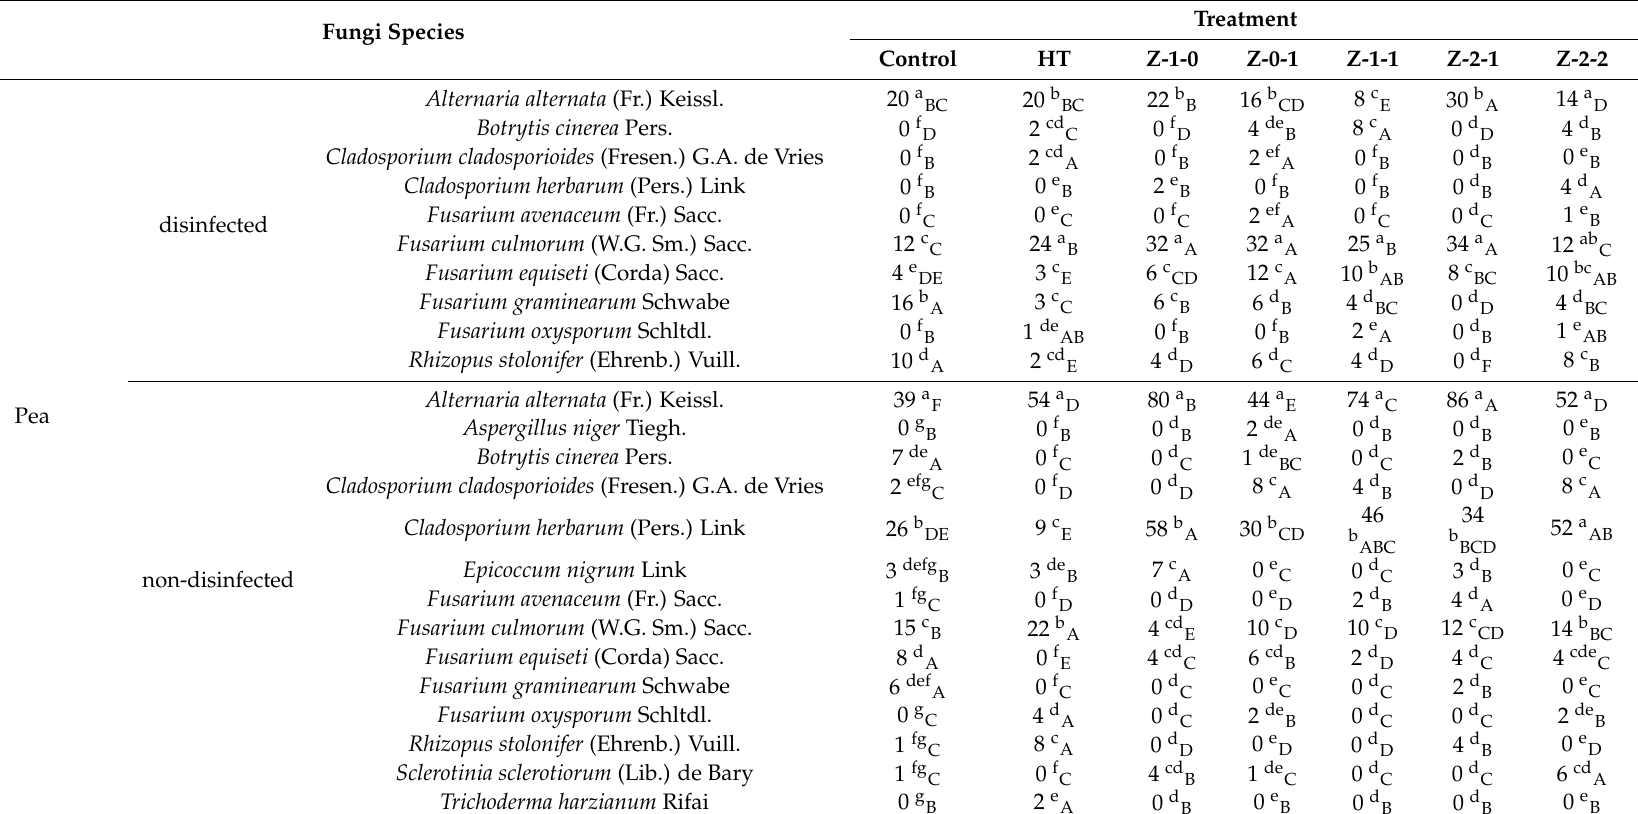
Table A3. Cont. Treatment Fungi Species Control HT Z-1-0 Z-0-1 Z-1-1 Z-2-1 Z-2-2 Alternaria alternata (Fr.) Keissl. 20 a BC 20 b BC 22 b B 16 b CD 8 c E 30 b A 14 a D Botrytis cinerea Pers. 0 f D 2 cd C 0 f D 4 de B 8 c A 0 d D 4 d B Cladosporium cladosporioides (Fresen.) G.A. de Vries 0 f B 2 cd A 0 f B 2 ef A 0 f B 0 d B 0 e B Cladosporium herbarum (Pers.) Link 0 f B 0 e B 2 e B 0 f B 0 f B 0 d B 4 d A Fusarium avenaceum (Fr.) Sacc. 0 f C 0 e C 0 f C 2 ef A 0 f C 0 d C 1 e B disinfected Fusarium culmorum (W.G. Sm.) Sacc. 12 c C 24 a B 32 a A 32 a A 25 a B 34 a A 12 ab C Fusarium equiseti (Corda) Sacc. 4 e DE 3 c E 6 c CD 12 c A 10 b AB 8 c BC 10 bc AB Fusarium graminearum Schwabe 16 b A 3 c C 6 c B 6 d B 4 d BC 0 d D 4 d BC Fusarium oxysporum Schltdl. 0 f B 1 de AB 0 f B 0 f B 2 e A 0 d B 1 e AB Rhizopus stolonifer (Ehrenb.) Vuill. 10 d A 2 cd E 4 d D 6 d C 4 d D 0 d F 8 c B Alternaria alternata (Fr.) Keissl. 39 a F 54 a D 80 a B 44 a E 74 a C 86 a A 52 a D Pea Aspergillus niger Tiegh. 0 g B 0 f B 0 d B 2 de A 0 d B 0 d B 0 e B Botrytis cinerea Pers. 7 de A 0 f C 0 d C 1 de BC 0 d C 2 d B 0 e C Cladosporium cladosporioides (Fresen.) G.A. de Vries 2 efg C 0 f D 0 d D 8 c A 4 d B 0 d D 8 c A 46 34 Cladosporium herbarum (Pers.) Link 26 b DE 9 c E 58 b A 30 b CD 52 a AB b b ABC BCD Epicoccum nigrum Link 3 defg B 3 de B 7 c A 0 e C 0 d C 3 d B 0 e C non-disinfected Fusarium avenaceum (Fr.) Sacc. 1 fg C 0 f D 0 d D 0 e D 2 d B 4 d A 0 e D Fusarium culmorum (W.G. Sm.) Sacc. 15 c B 22 b A 4 cd E 10 c D 10 c D 12 c CD 14 b BC Fusarium equiseti (Corda) Sacc. 8 d A 0 f E 4 cd C 6 cd B 2 d D 4 d C 4 cde C Fusarium graminearum Schwabe 6 def A 0 f C 0 d C 0 e C 0 d C 2 d B 0 e C Fusarium oxysporum Schltdl. 0 g C 4 d A 0 d C 2 de B 0 d C 0 d C 2 de B Rhizopus stolonifer (Ehrenb.) Vuill. 1 fg C 8 c A 0 d D 0 e D 0 d D 4 d B 0 e D Sclerotinia sclerotiorum (Lib.) de Bary 1 fg C 0 f C 4 cd B 1 de C 0 d C 0 d C 6 cd A Trichoderma harzianum